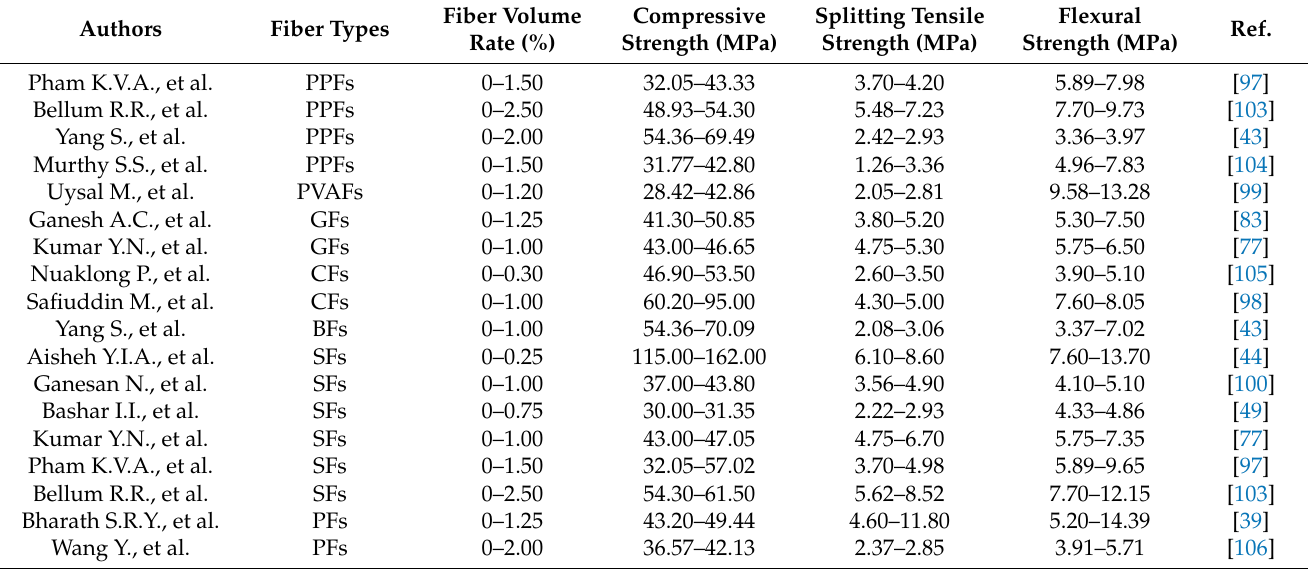
Table 8. The effect of fiber volume rate on geopolymer concrete.